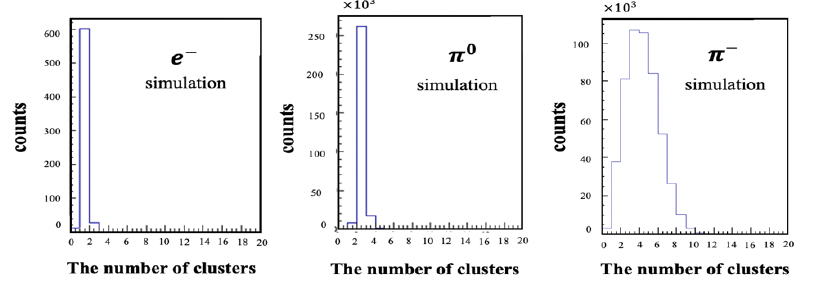
Fig. 4. The number of clusters in the BGO for the beta-decay electron, π & and π ’ from He !"